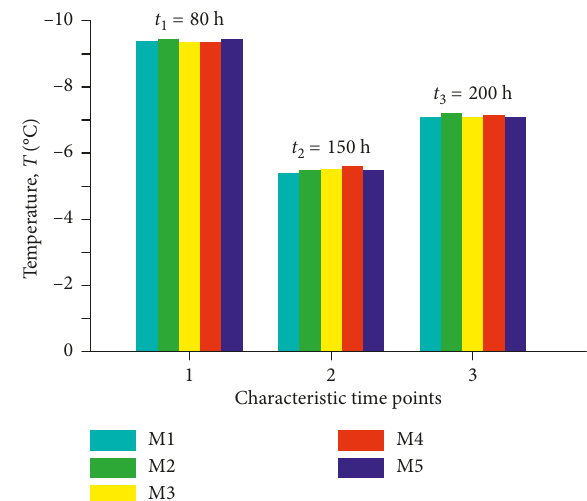
Figure 4: Comparison of temperatures in five monitoring